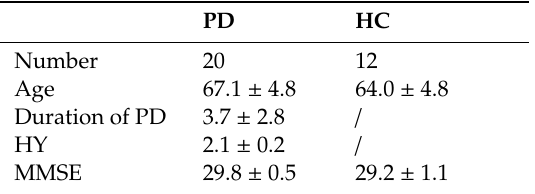
Table 1. Demographic and clinical features of the sample.